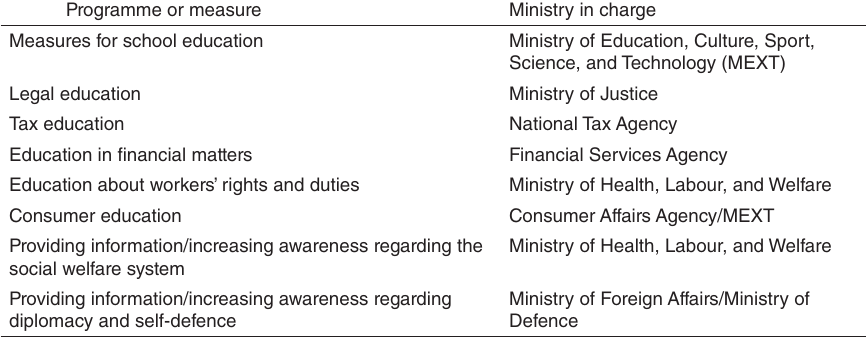
Table 1: Ministerial responsibility for social development and social participation